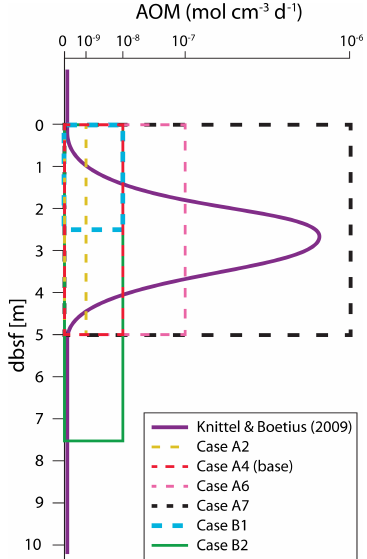
Figure 2. Conceptual AOM rate as a function of depth below seafloor (b.s.f., solid purple) based on Knittel and Boetius (2009) and a visual representation of some of the model simulation cases performed in the present study. In Cases A1–A7, the base of the SRZ is prescribed at 5mb.s.f. We simulate two cases (B1–B2) with the SRZ extending down to 2.5 and 7.5mb.s.f., respectively, both with an AOM max of 10 − 8 molcm − 3 d − 1 . Note that the x axis is non-linear and that all boxes (each representing a simulation case) have their upper left corner situated at the